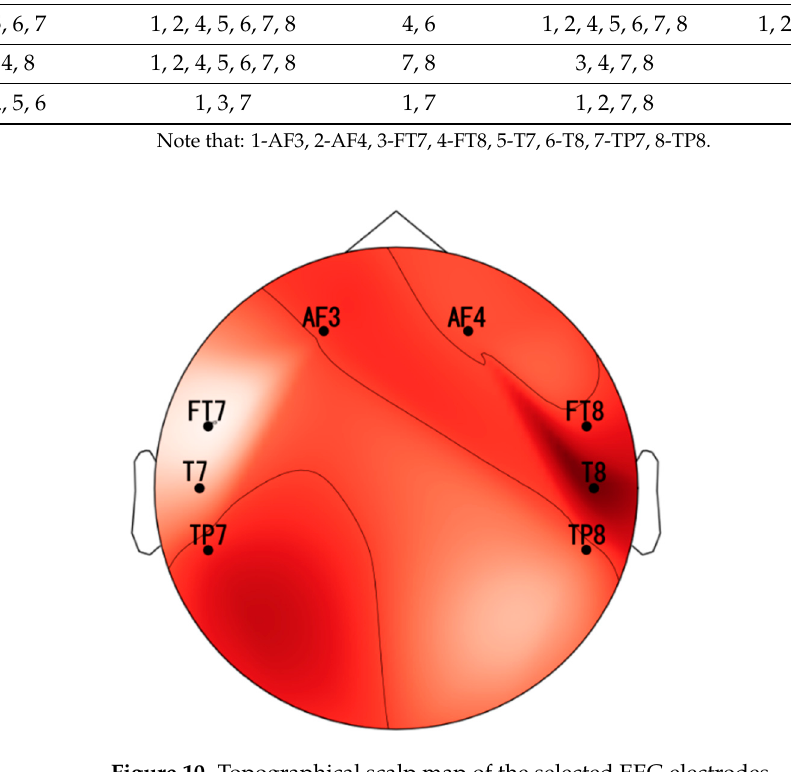
Figure 10. Topographical scalp map of the selected EEG electrodes.